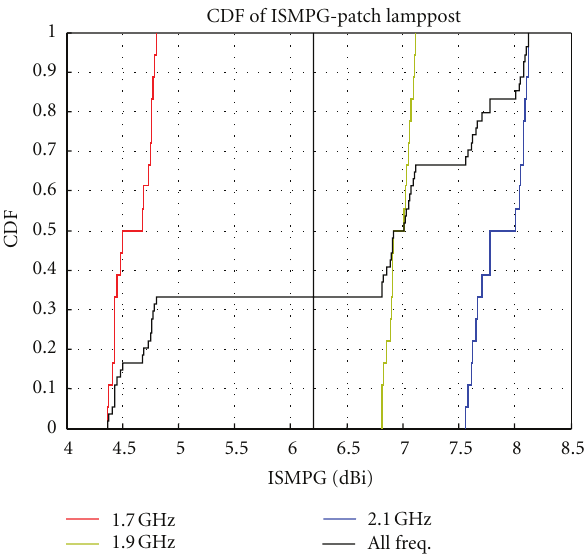
Figure 26: ISMPG distribution for patch-lamppost scenario. S 11 at 1.7 GHz, the curves are separated. A fitted Gaussian distribution has been plotted to illustrate that the aggregated ISSDPG is hard to be modeled by Gaussian distribution.